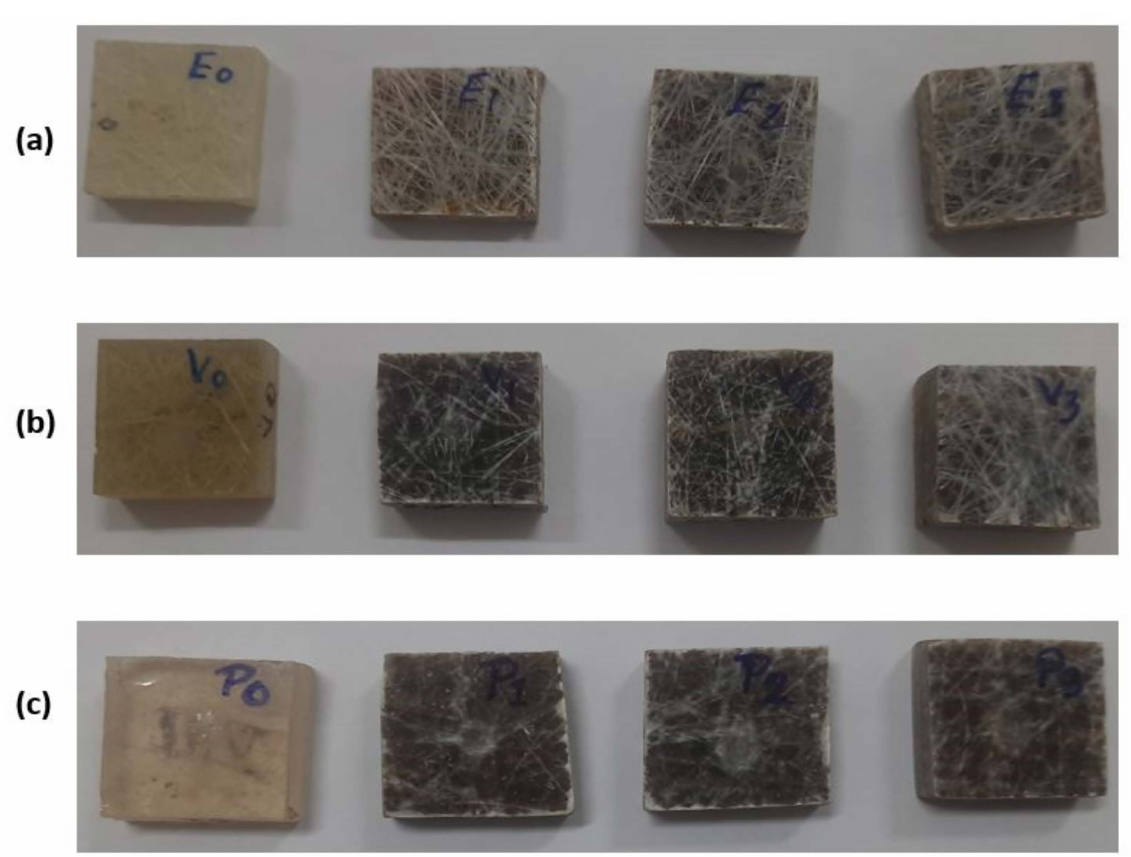
Figure 4. ( a ) Epoxy based, ( b ) vinyl ester based and ( c ) poly ester-based sample for erosive wear